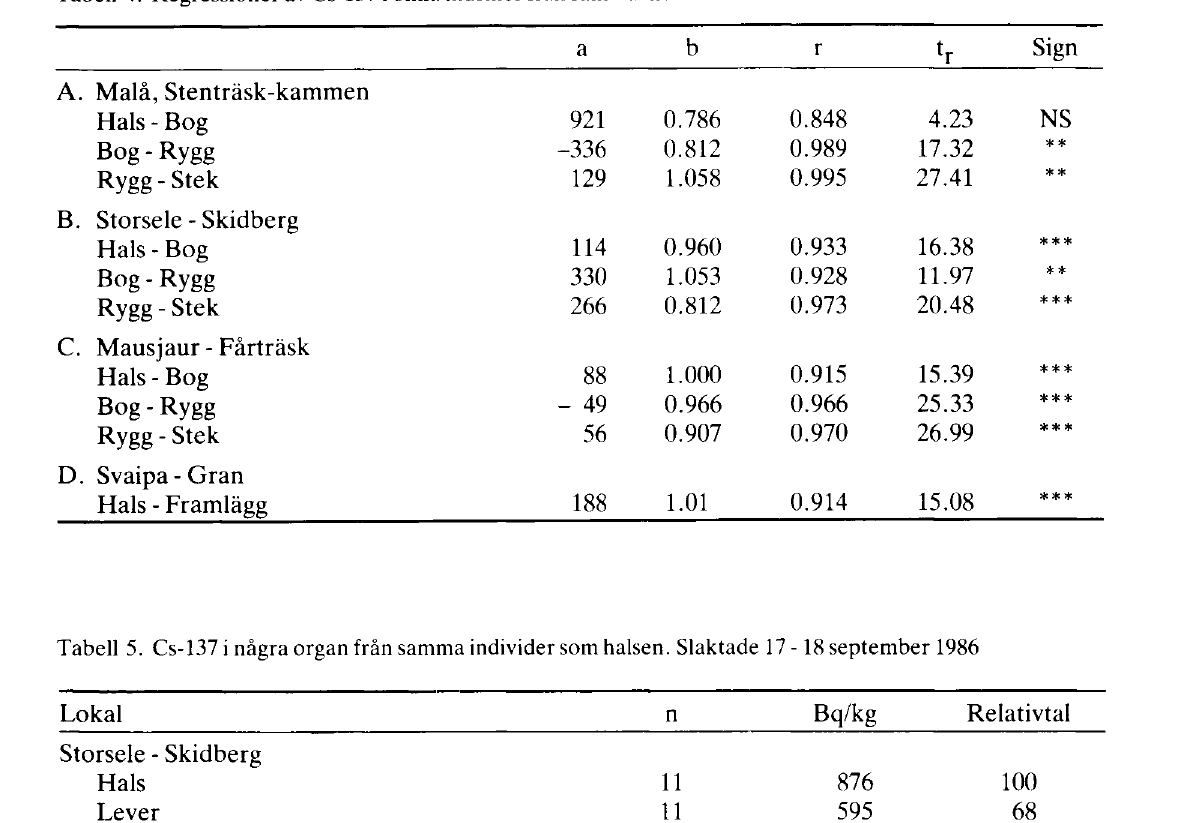
Tabell 6. Cs-137 i vaja med foster Lokal och datum